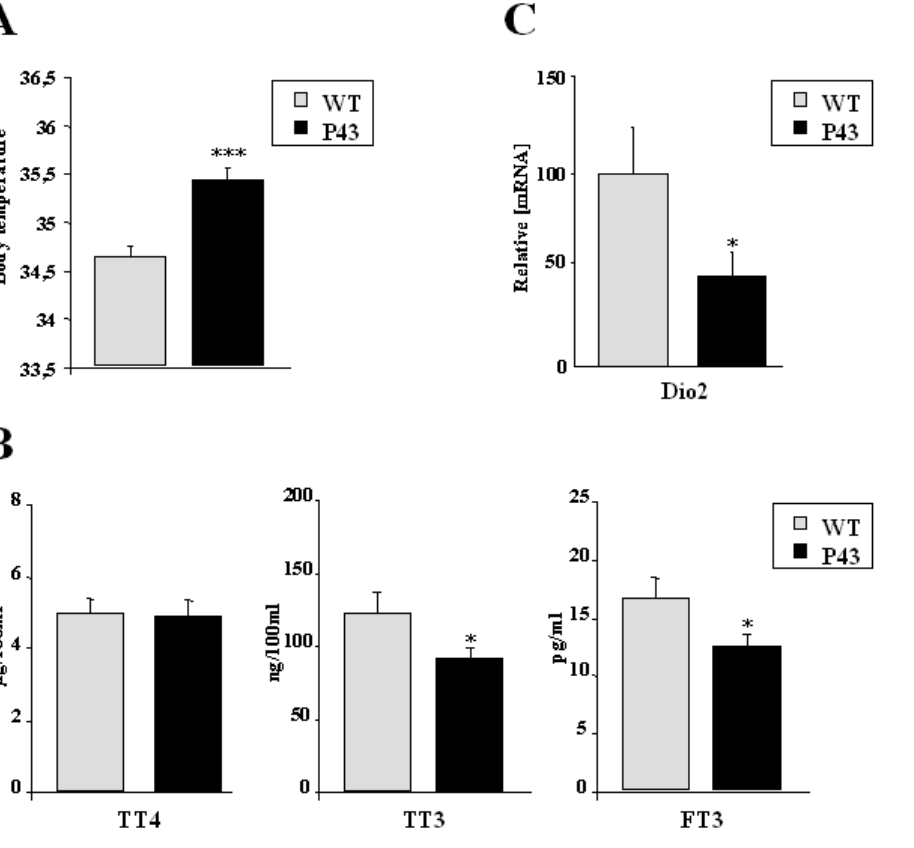
Figure 5. p43 overexpression increases body temperature. (A) Body temperature from transgenic mice of the 86 line compared to wild-type animals at 2 months of age. ***p , 0.001. (B) Levels of total T4, total T3 and free T3 in serum from transgenic mice of the 86 line compared to wild- type animals at 2 months of age (n=8 each group). T4, total T3 and free T3 were measured using a direct competitive radioimmunoassay from MP- Biomedicals. *p , 0.05. (C) Relative mRNA expression levels of type 2 iodothyronine deiodinase (Dio2) in quadriceps from transgenic mice of the 86 line compared to wild-type animals at 2 months of age (n=8 each group). *p , 0.05.